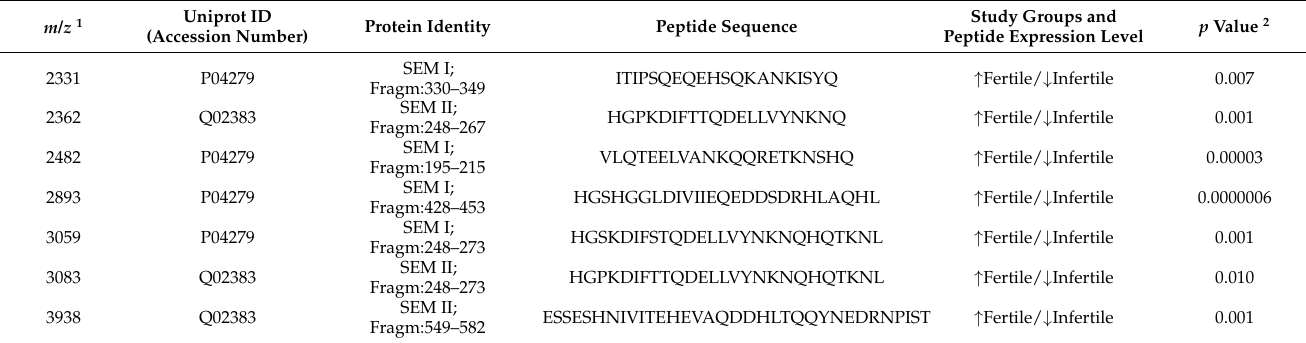
Table 2. Discriminant peaks significantly different between fertile (n. 15) and infertile (n. 15)